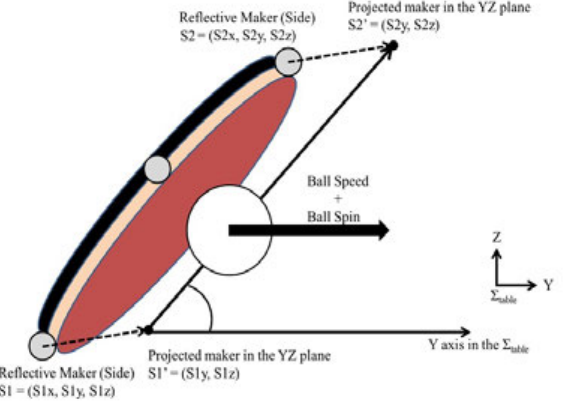
Figure 5. Racket angle calculation All six variables from the human testing (racket speed and angle, hitting height and distance from table, ball speed and spin) were analysed using a 2 (ball types) x 2 (ball spin) x 2 (skill) mixed model analysis of variance (ANOVA). Main effects and interactions were subjected to Bonferroni post hoc tests and effect sizes were calculated using partial eta squared ( for omnibus comparisons. The level for significance